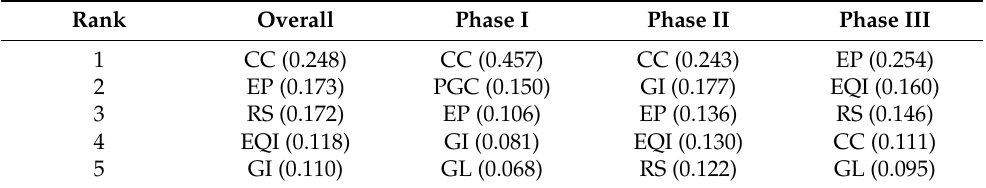
Table 3. Betweenness centrality of policy goals in the 2-mode